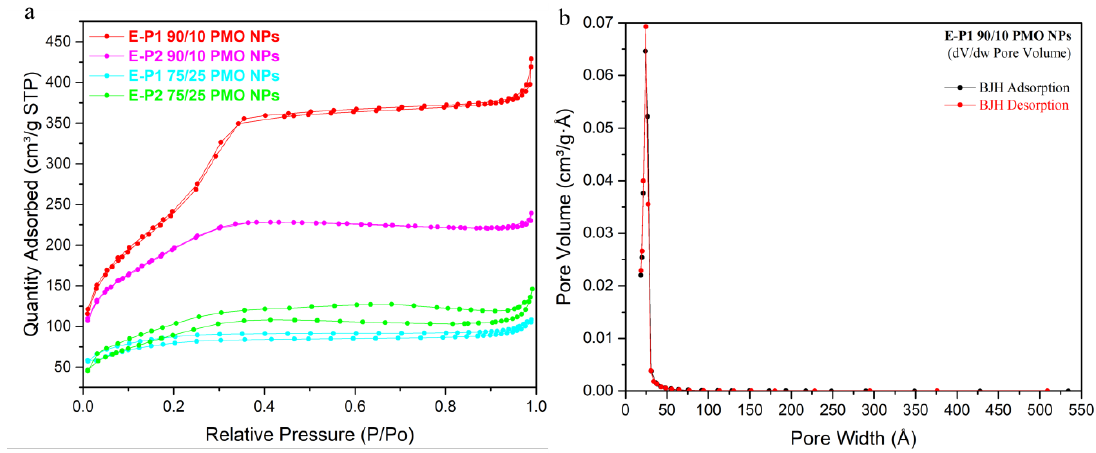
Figure 3. ( a ) N 2 -sorption isotherms of E-Pn PMO NPs ; ( b ) BJH dV / dw Pore Volume of E-P1 90 / 10 PMO NPs.